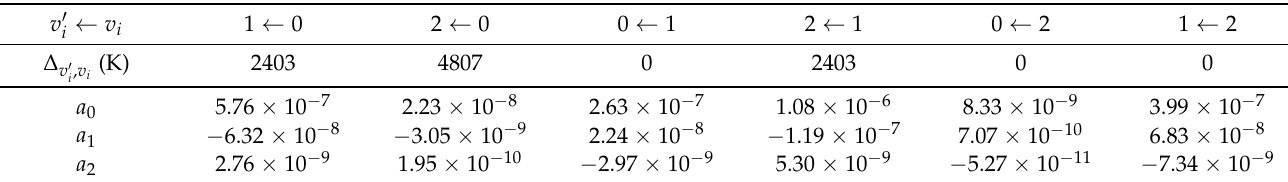
( x ) of Equations (5) and (6) between the three lowest vibrational υ i (cid:48) υ i in Equation (7). i (cid:48) ← υ i